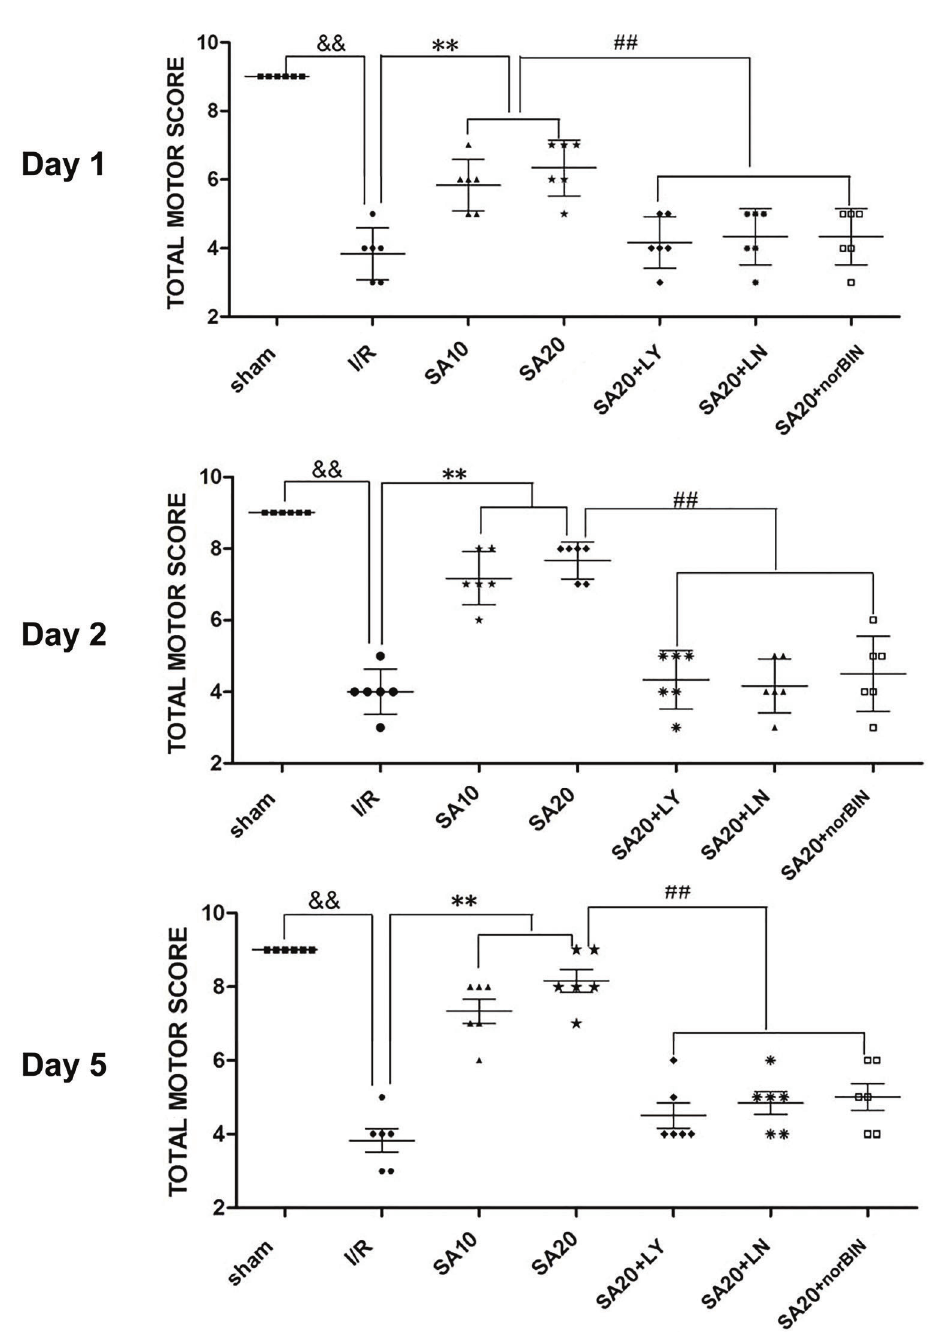
Figure 8. Effect of salvinorin A treatment on motor function was evaluated on days 1, 2, and 5 after forebrain ischemia. SA10, SA20, SA20 + LY294002, SA20 + L-NAME, SA20 + norBIN were administered and the motor function of rats with forebrain ischemia was evaluated. Horizontal bars represent the group median values and symbols represent values for individual rats in each treatment group. && P o 0.01 compared to the sham control group, **P o 0.01 compared to the IR (ischemia reperfusion control, DMSO) group, ## P o 0.01 compared to the salvinorin A20 treatment group. Motor function tests were analyzed using Tukey ’ s multiple comparison test. LY: LY294002 (10 m M, injected topically); LN: L-NAME (10 m M, injected topically); IR (DMSO): 1 m L/kg ( iv ); SA10: salvinorin A (10 m g/kg, iv ); SA20: salvinorin A (20 m g/kg, iv ); norBIN: norbinaltorphimine 1 m M (injected